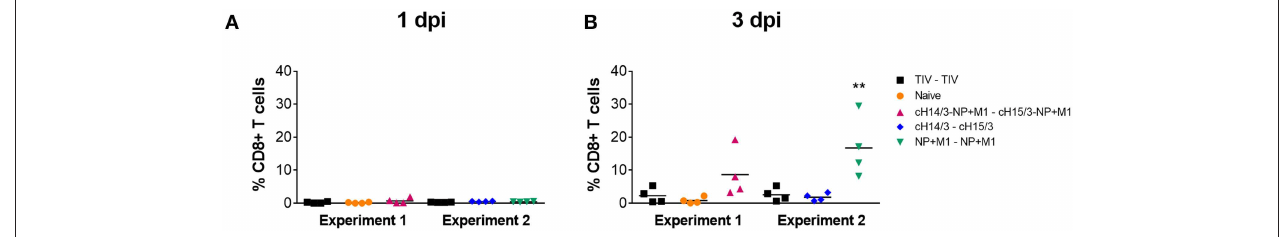
FIGURE 5 | Influenza virus specific T cells in the nasal washes. TIV vaccinated, viral vector vaccinated (cHA-NP + M1, cHA, or NP + M1), and naïve ferrets were challenged IN with 10 6 PFU of A/Wyoming/03/2003 (H3N2) virus and nasal washes were collected at days 1 and 3 post-challenge. Cells were isolated from these nasal washes and stimulated with peptide arrays spanning the NP + M1 fusion protein. Following stimulation, cells were stained with anti-CD8 and -IFN- γ antibodies and influenza virus-specific IFN- γ + CD8 + T cells were measured at days 1 (A) and 3 (B) post-challenge. The data are presented as individual replicates and the mean for each group is presented as line. n = 4 ferrets/group. ** p < 0.01 when naïve controls were compared to individual vaccination groups as determined by one-way analysis of variance, followed by a Bonferroni multiple-comparison test.